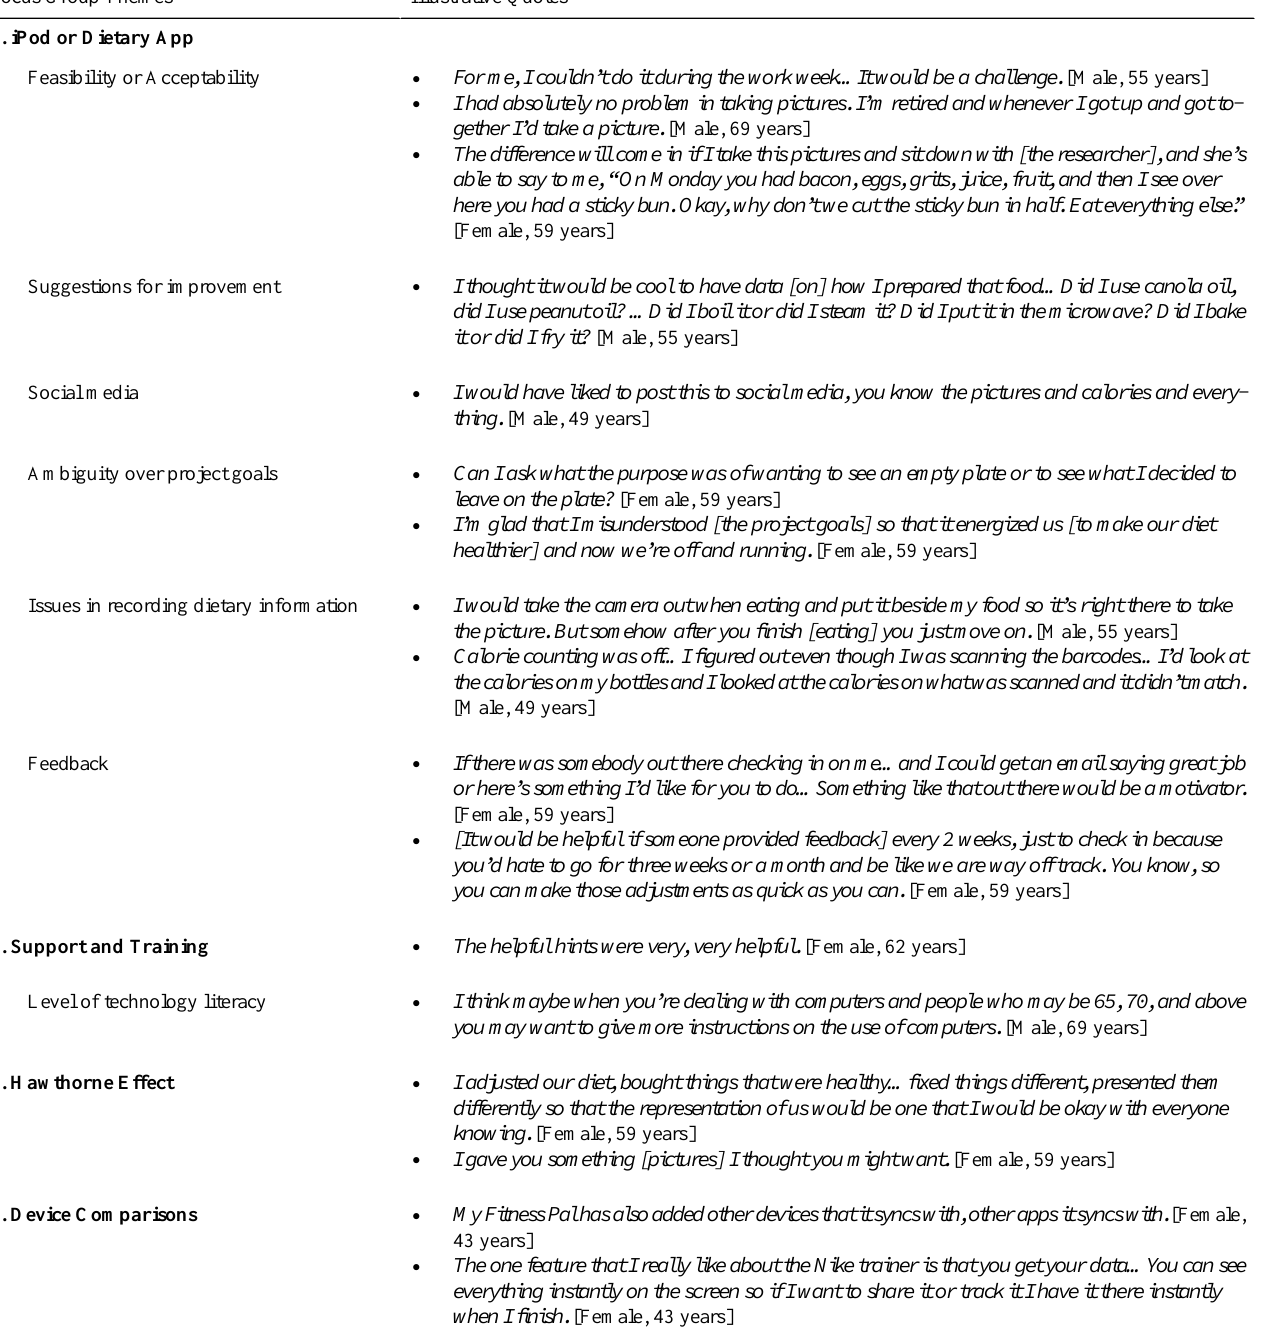
Illustrative QuotesFocus Group